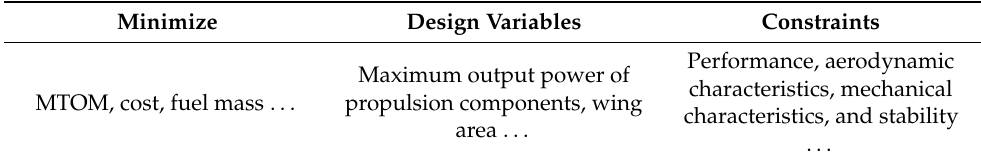
Table 2. Design optimization problem Data from [19].